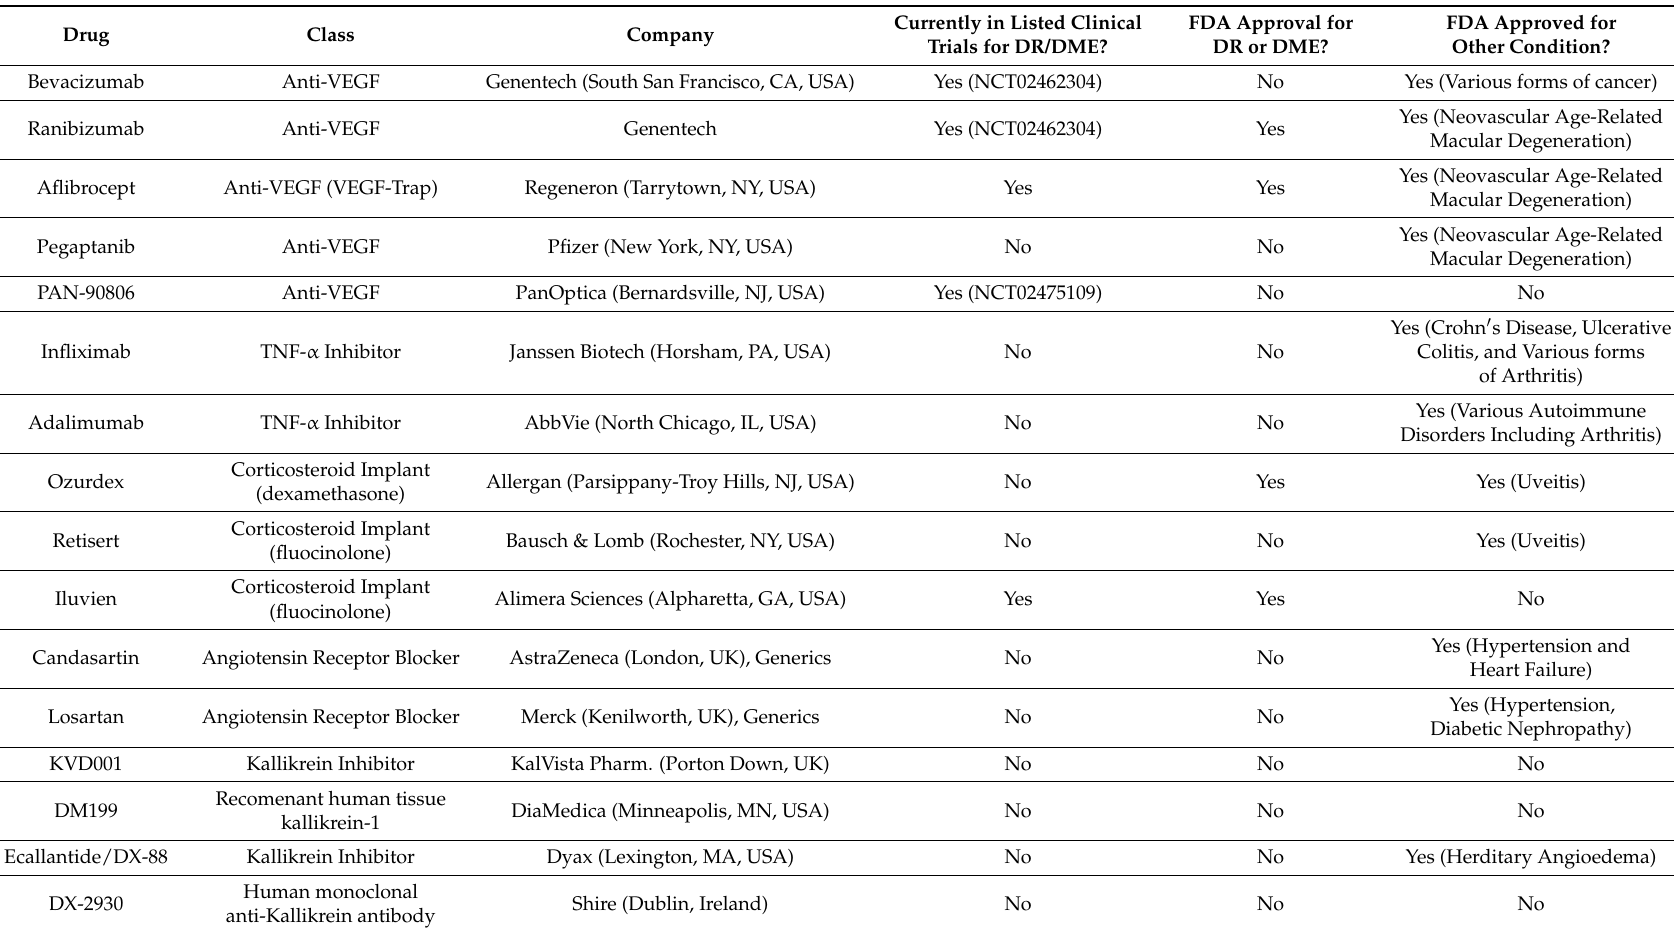
Table 1. Selected pharmacological therapies for the treatment of DR/DME. List of various pharmacological agents indicated for treatment of DR/DME along with drug class, company, clinical trial status, and FDA approval information. Drugs listed as currently in trials for DR/DME must have been listed in a DR/DME specific trial in May 2016 on